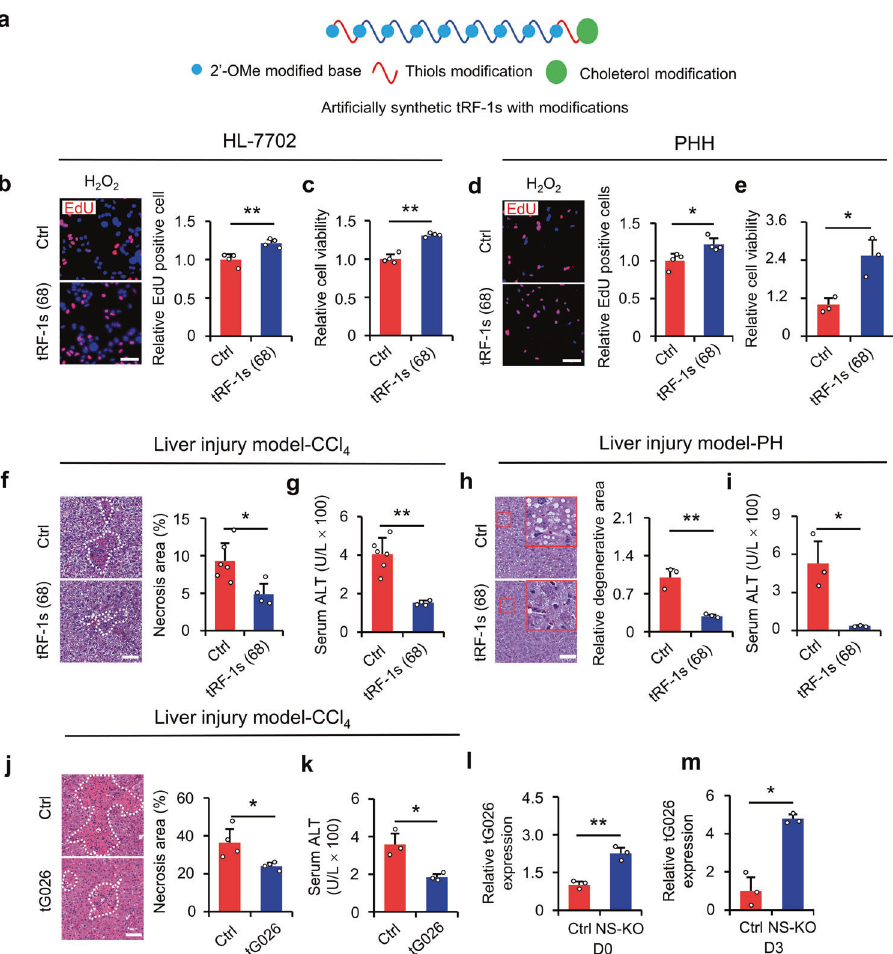
Fig. 5 Screened tG026 promoted cell proliferation and survival after injury. a The modi fi ed pattern of arti fi cially synthesized tRF-1s. b HL-7702 cells were transfected with 68 arti fi cially synthesized tRF-1s. Random code sequence was used as a negative control. EdU-positive cells were analyzed relative to the control. n = 4 replicates. Representative images (left panel) and statistical results (right panel) are shown. Scale bar, 100 μ m. c Relative cell viability (CCK-8 assay) was assessed by detecting the OD450 value. n = 4 replicates. d The results of ( b ) in PHH cells. n = 4 replicates. e The results of ( c ) in the PHH cells. n = 3 replicates. f , g The effects of injection of 68 synthetic tRF-1s with modi fi cations in vivo in